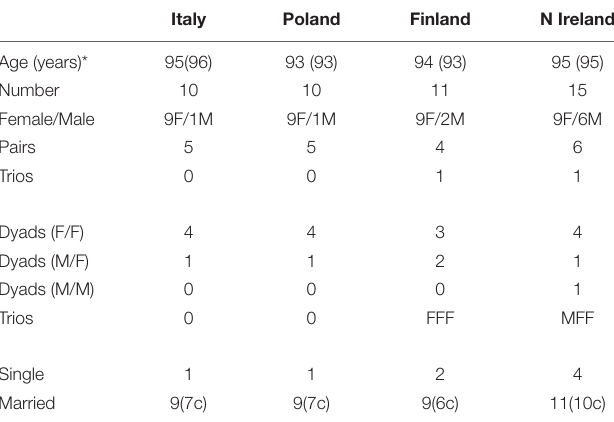
TABLE 1 | Comparative age, sex and male/female, female/female, male/male dyads and trios for nonagenarian siblings in Italy, Poland, Finland, and Northern